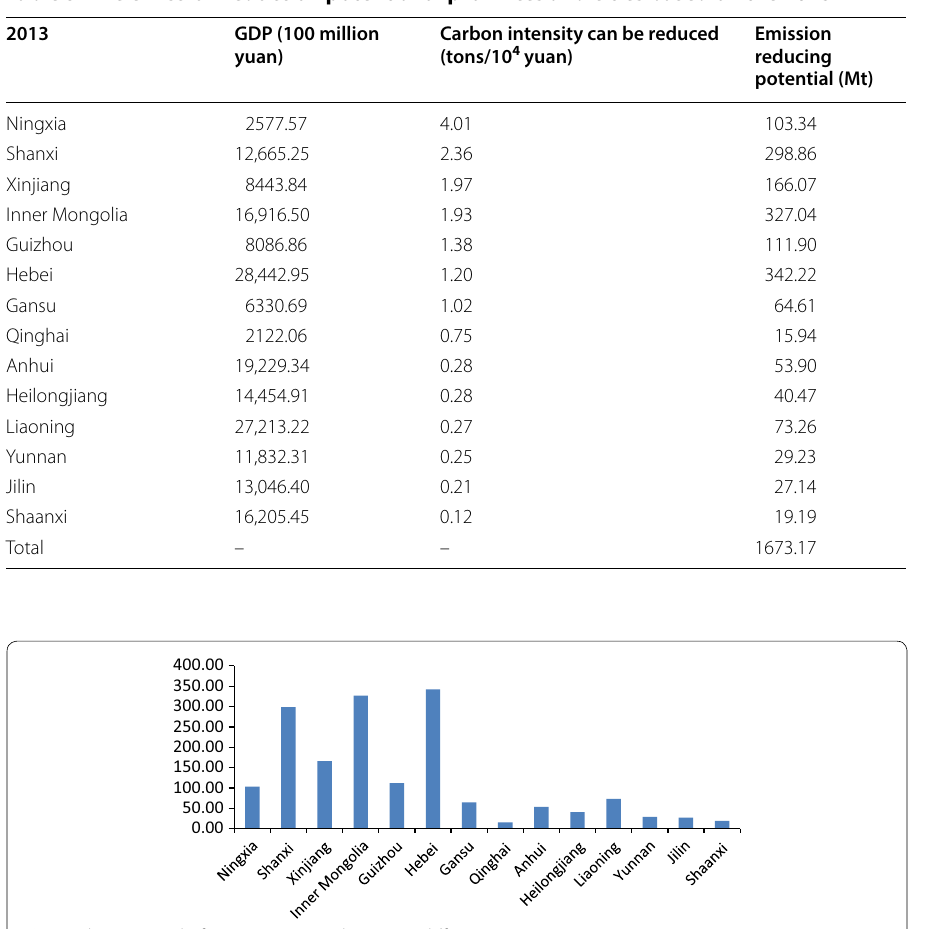
Table 3 The emission reduction potential of provinces and cities based on the 2013 2013 GDP (100 million